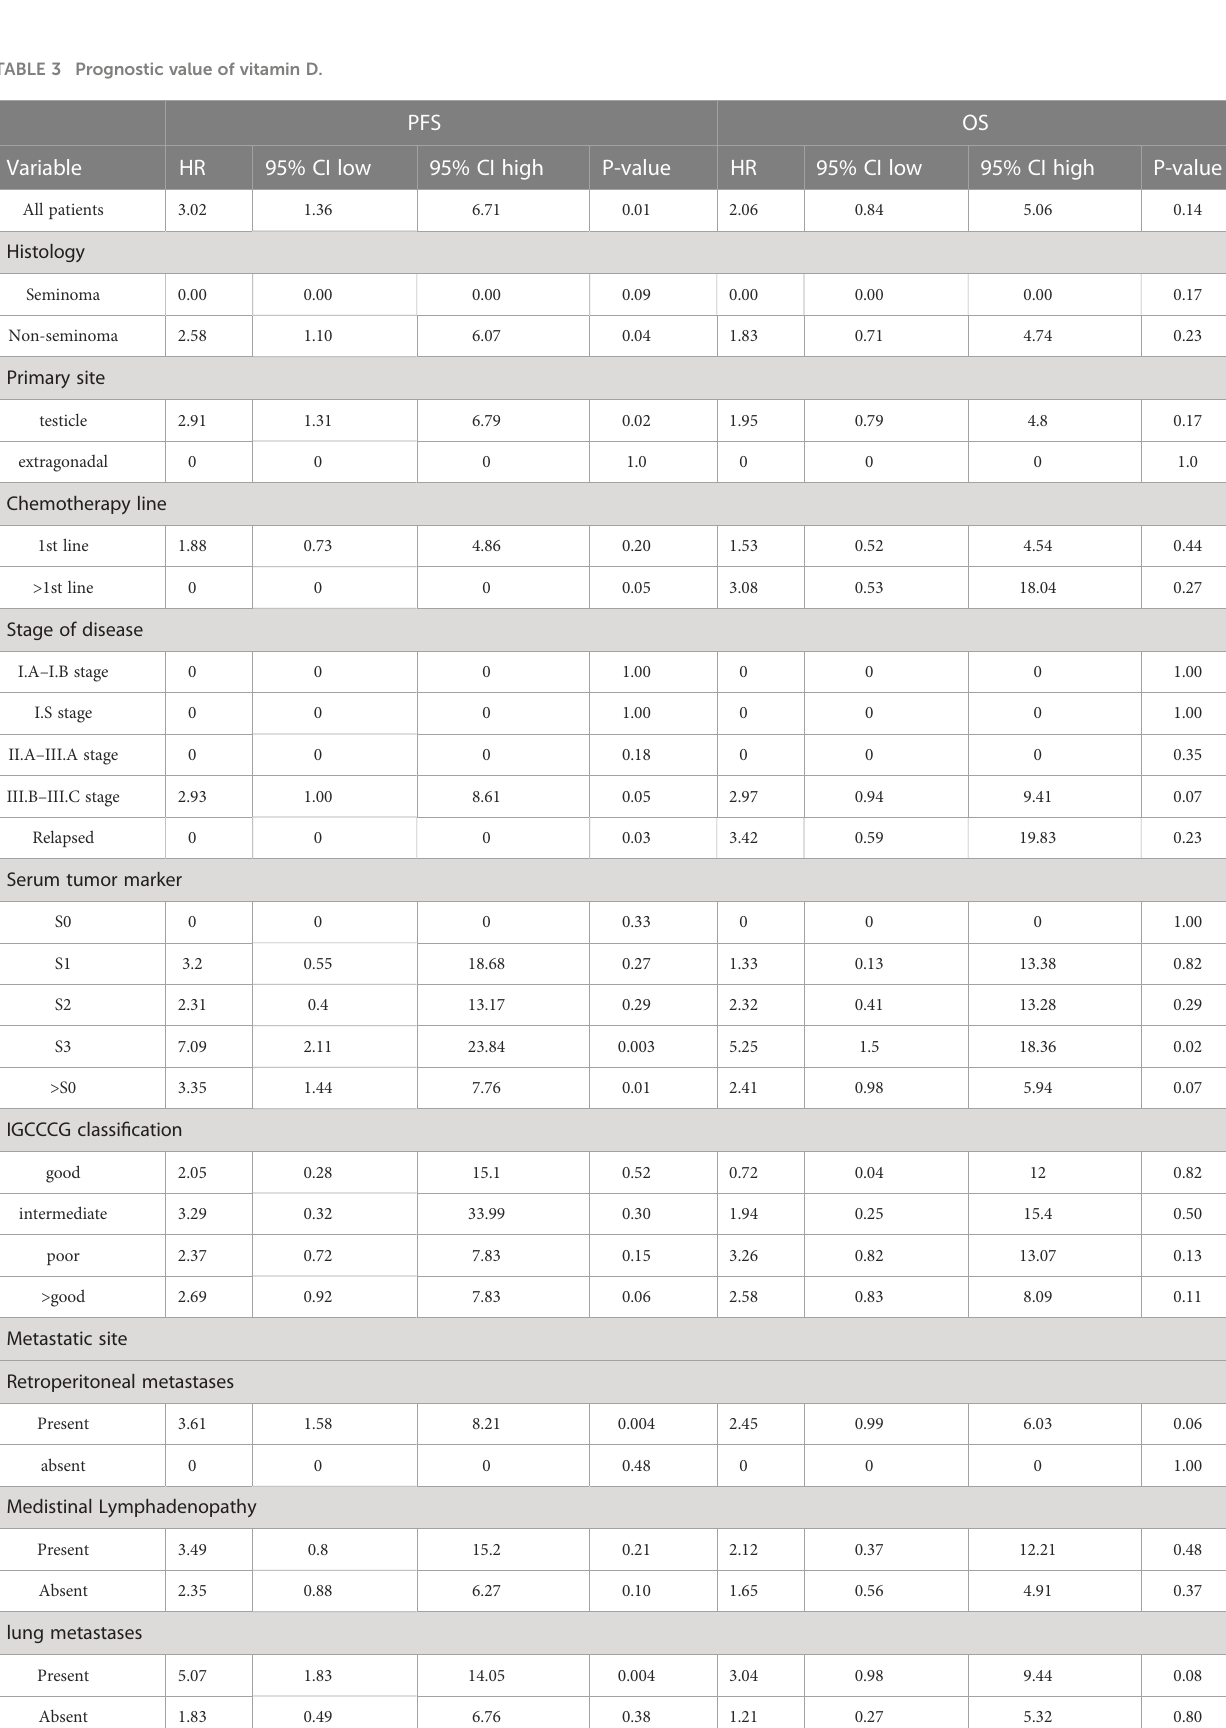
TABLE 3 Prognostic value of vitamin D. PFS